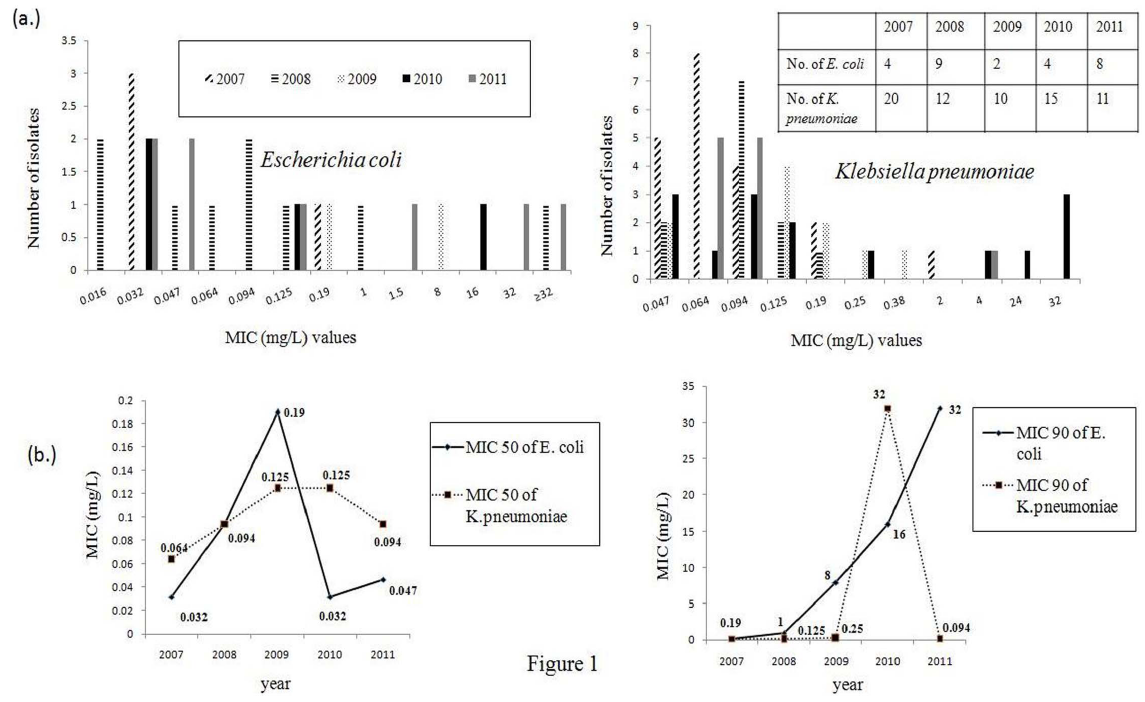
Figure 1. Meropenem MIC values : (a) Distribution of Meropenem MIC values among 27 E . Coli isolates and 68 K.pneumoniae isolates as determined by the Etest method during the study period (2007–2011); (b) Graphical representation of MIC50 and MIC90 values of the isolates throughout five year period.